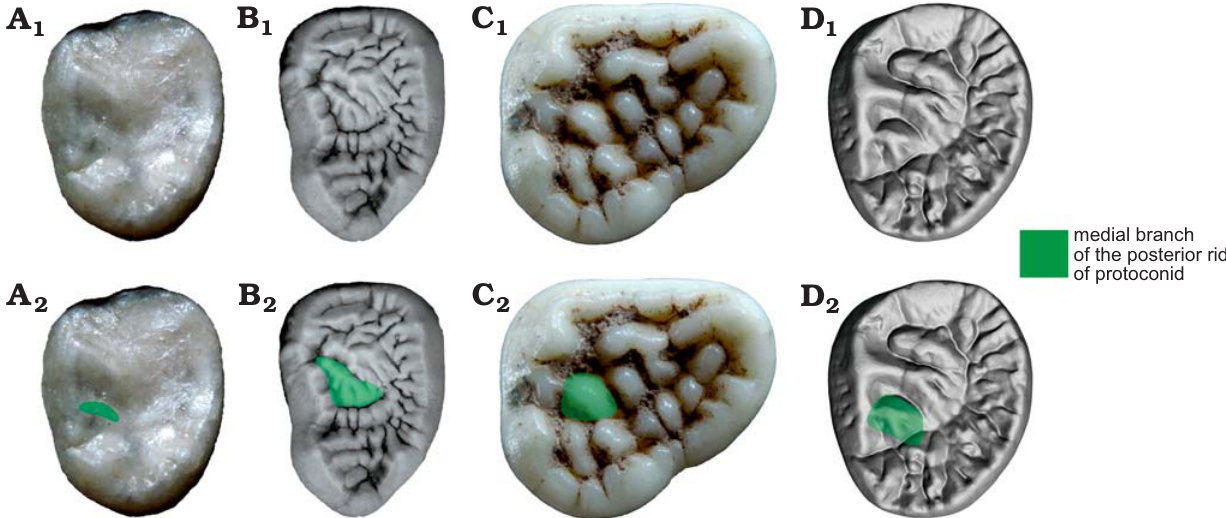
Fig. 12. Occlusal views of m3 homologous structures in cave bear (A, B) and giant panda (C, D) lineages. A . Ursavus tedfordi Qiu, Deng, and Wang, 2014 (HMV1453) from Huaigou, Gansu Province, Late Miocene. B . Ursus deningeri von Reichenau, 1904 (NMM1953/54, photo Jan Wagner) from Mosbach 2, Germany, early Middle Pleistocene. C . Ailuropoda melanoleuca (David, 1869) (IVPP V87025.362) from cave deposit of Guangxi Province, Late Pleistocene. D . Ailurarctos lufengensis Qiu and Qi, 1989 (IVPP V6892) from Lufeng, Yunnan Province, Latest Miocene. A 1 –D 1 , photographs; A 2 –D 2 , photographs with homologous structures indicated. Not to